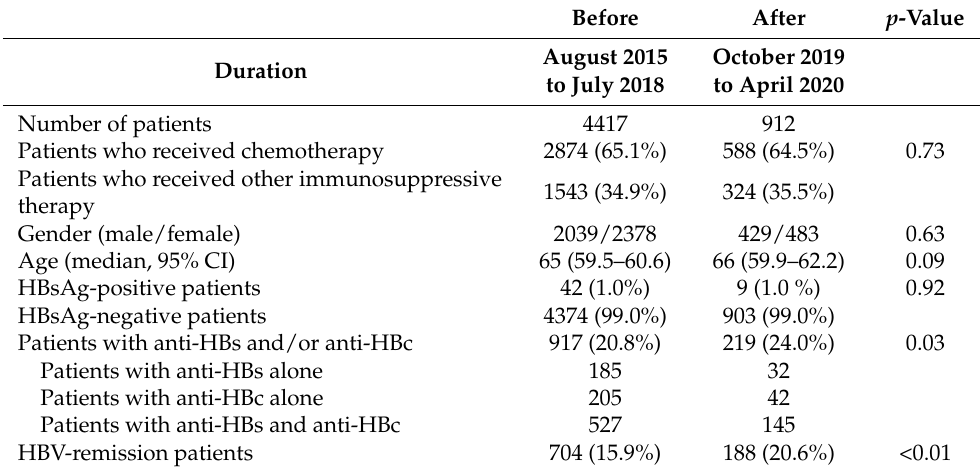
Table 1. Baseline characteristics of patients before and after the introduction of the alert